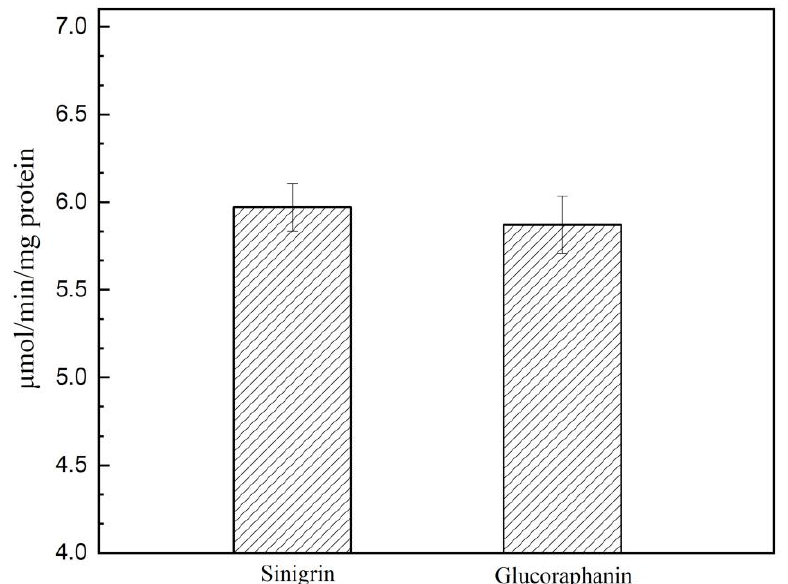
Figure 5. Hydrolysis of sinigrin and glucoraphanin by Shewanella baltica Myr-37 myrosinase toward sinigrin compared with glucoraphanin. Purified Smyr37 (2 µ g) was added to the mixture of sinigrin/glucoraphanin (5 mM) in PBS to make a final volume of 1 mL.